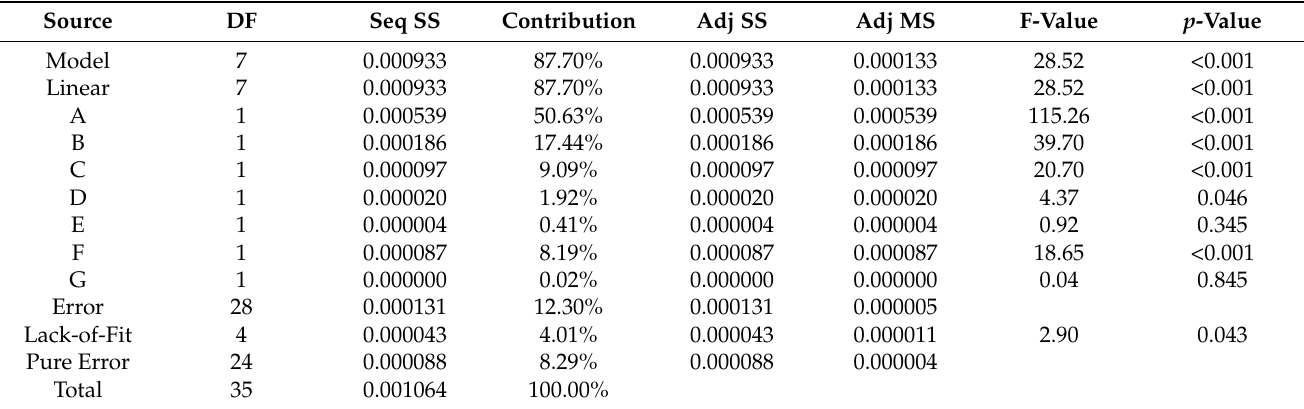
Table 10. The ANOVA table for the PB design of mineral